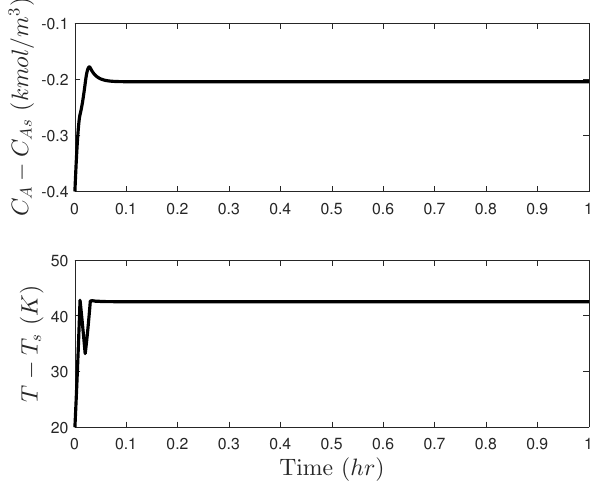
Figure 4. State trajectories under the single Lyapunov-based model predictive controller (LMPC) for the CSTR of Equations (46) and (47).